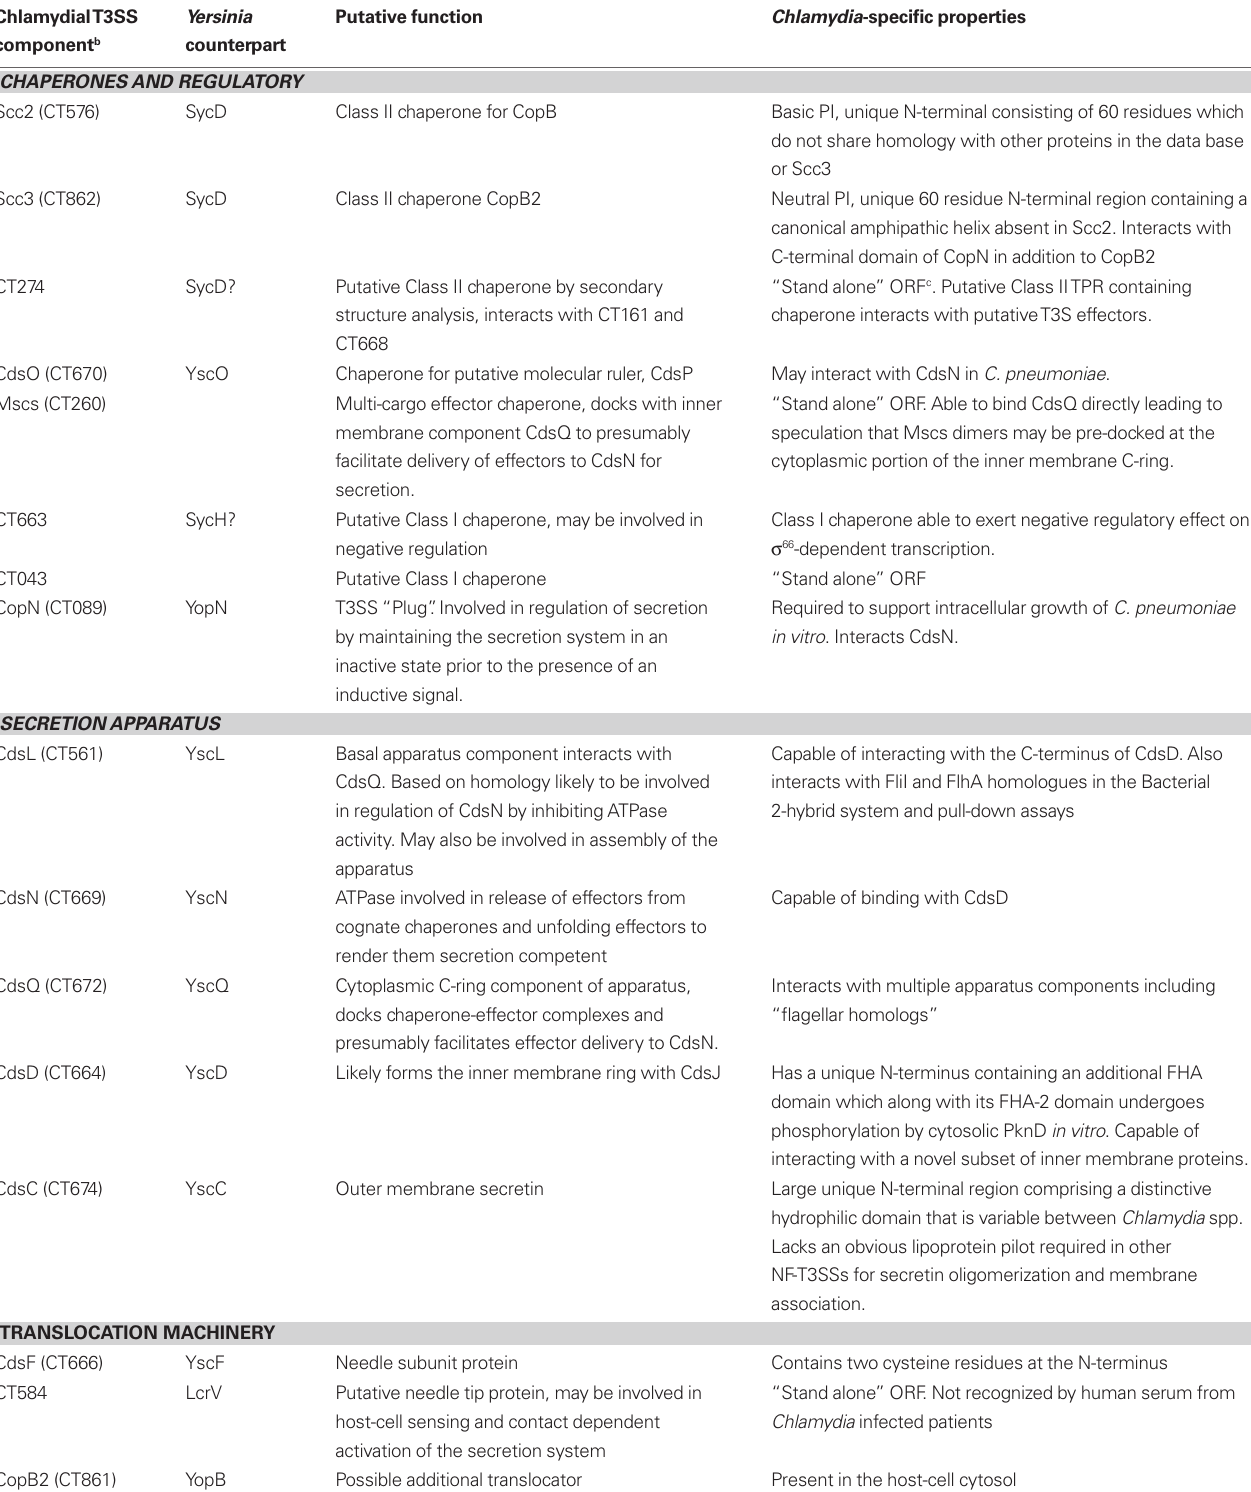
Table 1 | Distinguishing features of Chlamydia T3SS components a